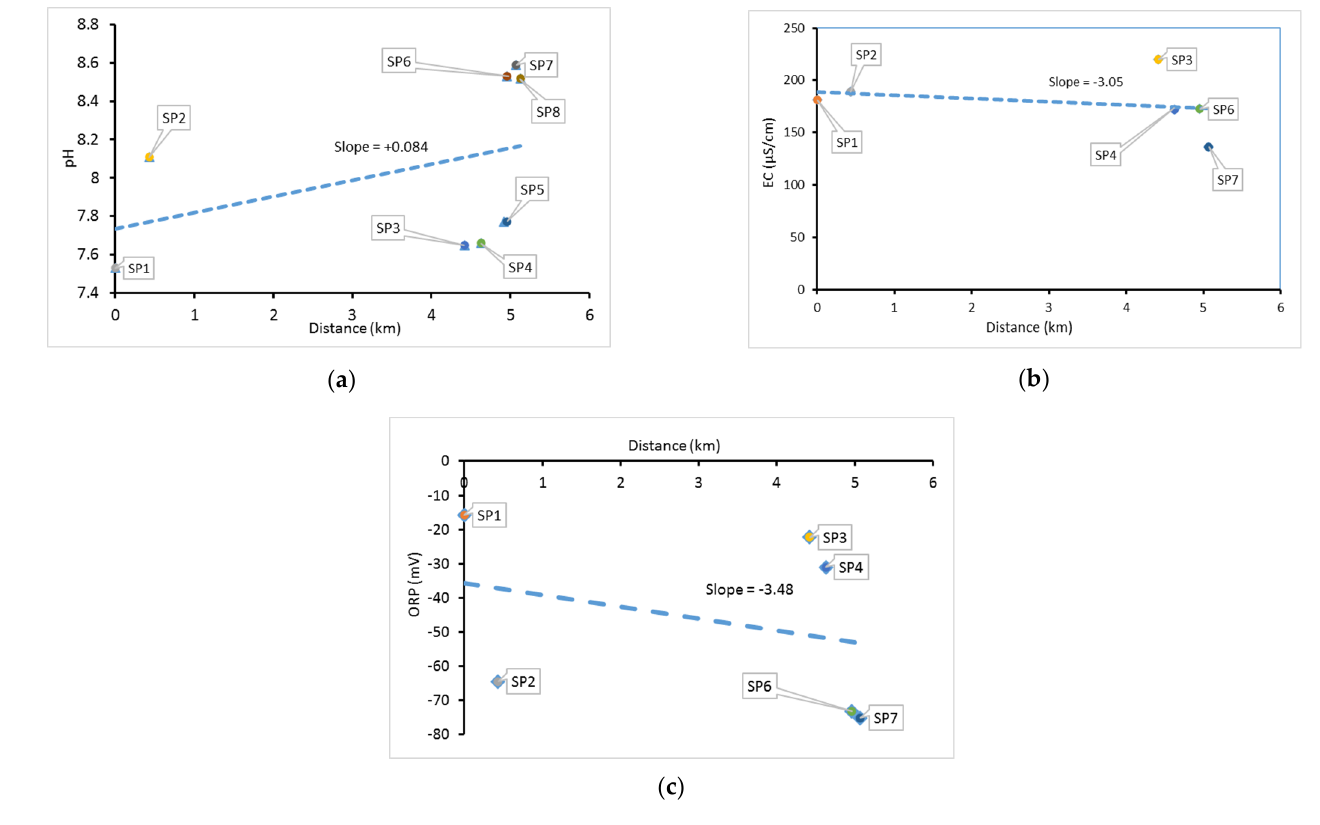
Figure 11. pH ( a ), EC ( b ) and ORP ( c ) variation along the flow path.